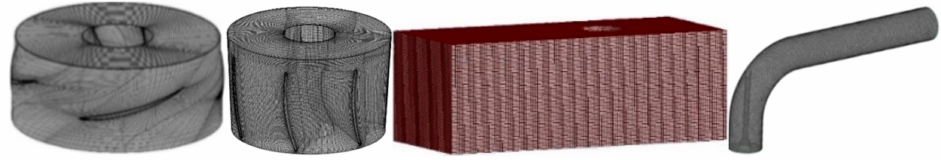
Figure 3. Grid diagram of a calculation